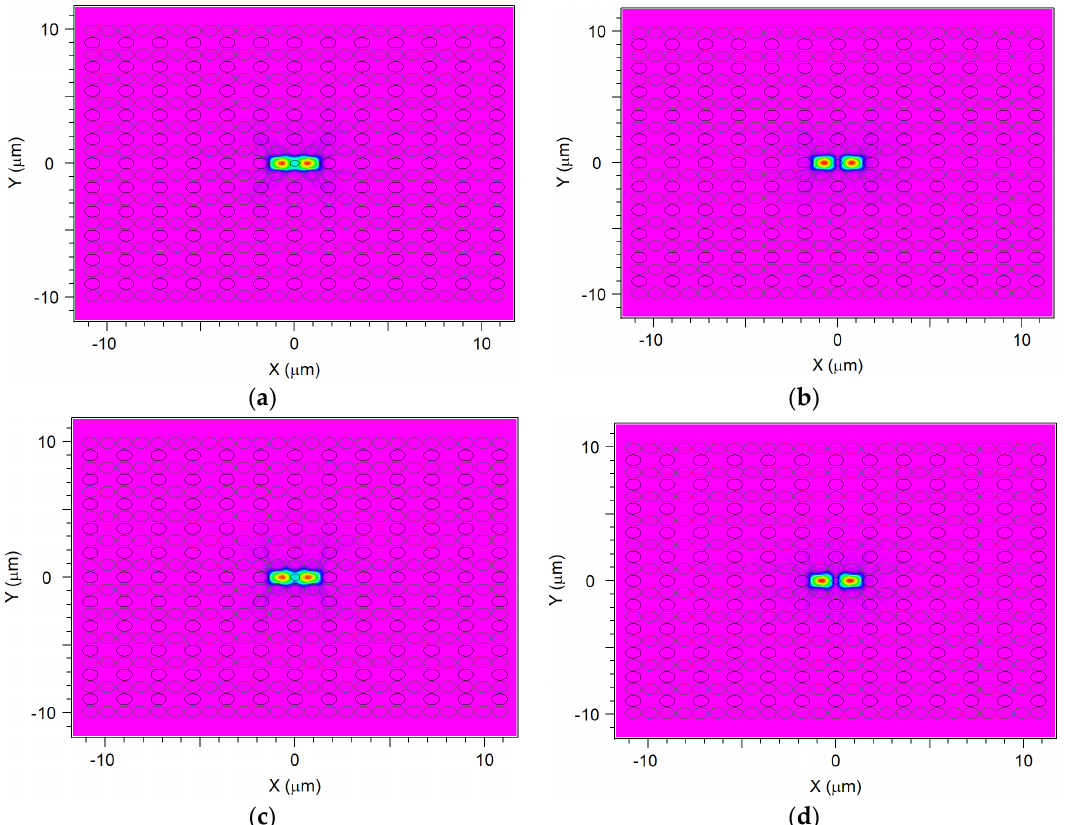
Figure 9. ( a ) Even-mode of x -direction, ( b ) odd-mode of x -direction, ( c ) even-mode of y -direction, ( d ) odd-mode of y -direction for coupler.